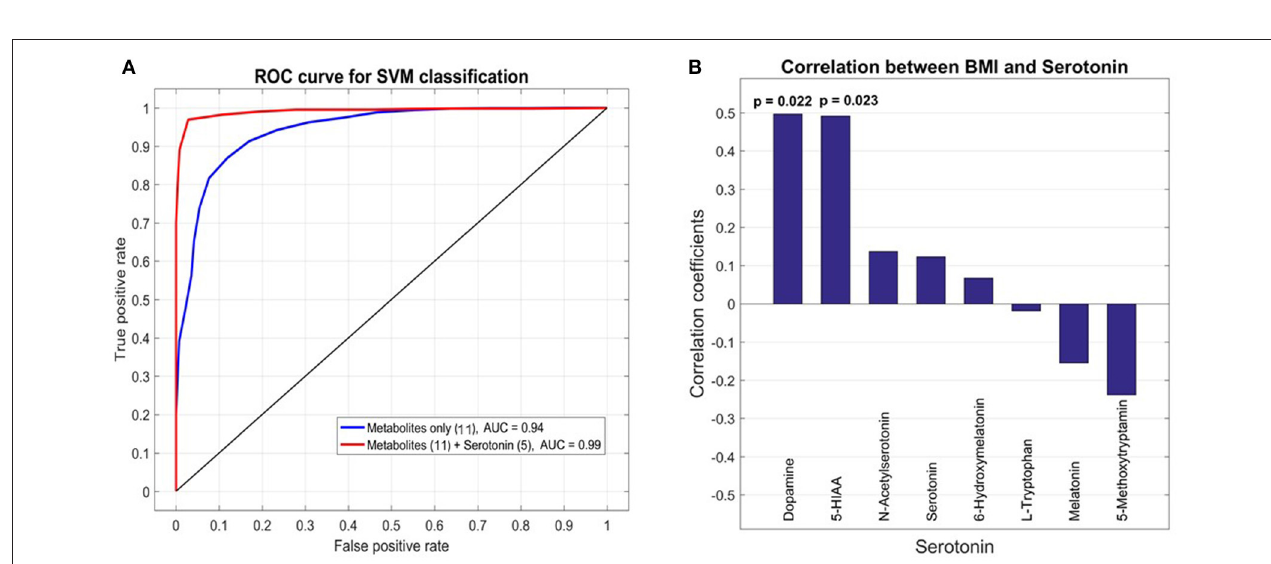
FIGURE 4 | Receiver operating characteristic (ROC) analysis of selected metabolites from plasma and urine samples of GDM vs. control patients. (A) Area under curve (AUC) for selected metabolites from plasma analysis and combined analysis of selected analysis of plasma and urine analysis. The final AUC is 0.99. Selection of variables was performed by LASSO regression (see section Materials and Methods). 11 Metabolites from blood samples and 5 metabolites from urine samples were selected (for further information see results and discussion). (B) Correlation analysis of serotonin, associated metabolic intermediates and dopamine measured in urine with BMI. The strongest correlation is found for